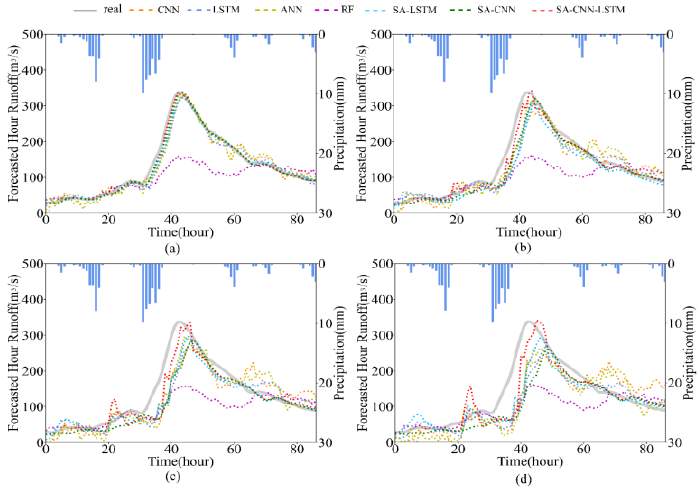
Figure 10. Comparisons of the predictions of the flood event (2021053000) from each model at the